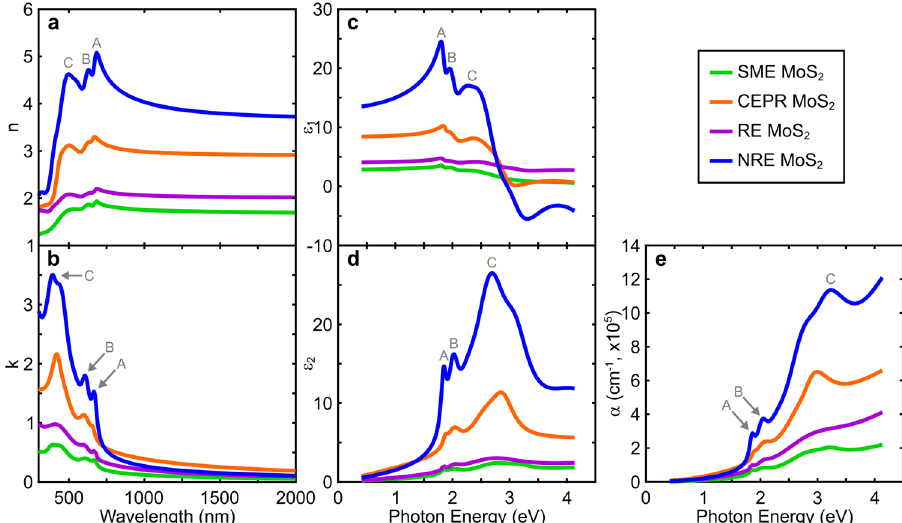
Fig. 2 Optical properties of exfoliation procedure-dependent MoS 2 thin fi lms. a , b Optical constants, n and k , c , d dielectric functions, ε 1 and fi cients, α , of MoS fi lms derived from variable angle spectroscopic ellipsometry optical dispersion data analysis. The ε 2 , and e absorption coef 2 A, B, and C excitons are indicated with respect to NRE MoS 2 , which yields the most distinctive optical pro fi